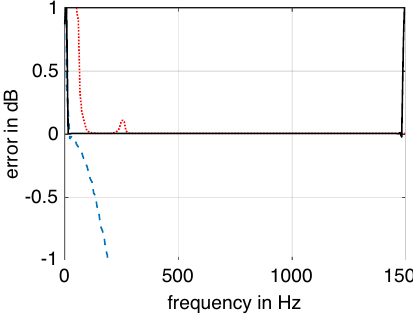
Figure 9. Error in the reconstructed source spectrum for the original IRFs (dotted line), after applying a lowpass fi lter to the IRFs with a cut off frequency of 200 Hz (dashed line) and after integrating the IRFs (solid